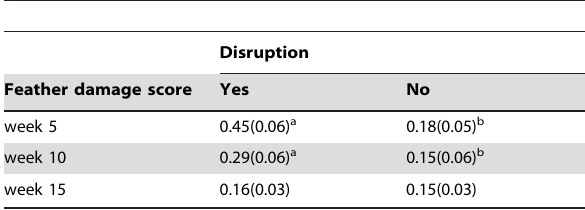
Table 2. Feather damage score at week five, ten and fifteen of age in relation to litter disruption.